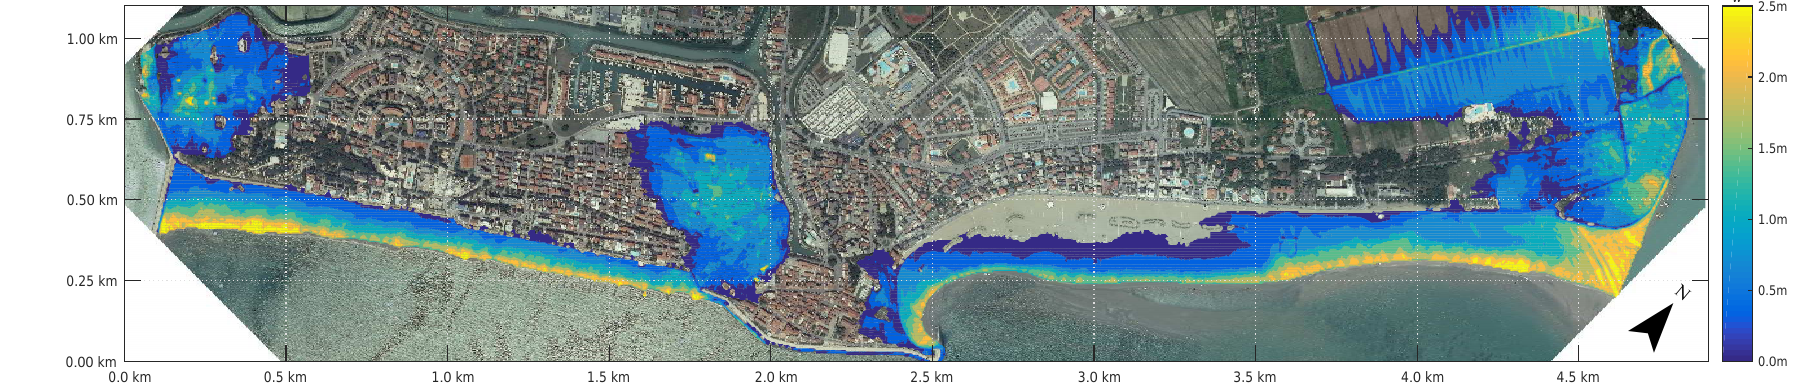
Figure 12. Flooding map (cell VE3): Hs = 6 m, ζ = 1.5 m ZMPS.